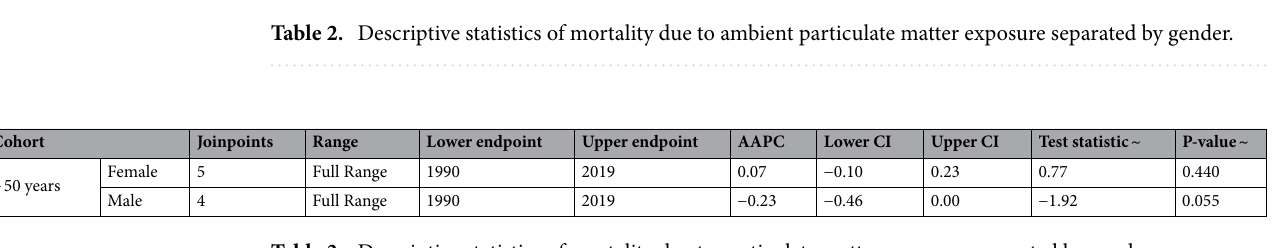
Table 3. Descriptive statistics of mortality due to particulate matter exposure separated by gender.